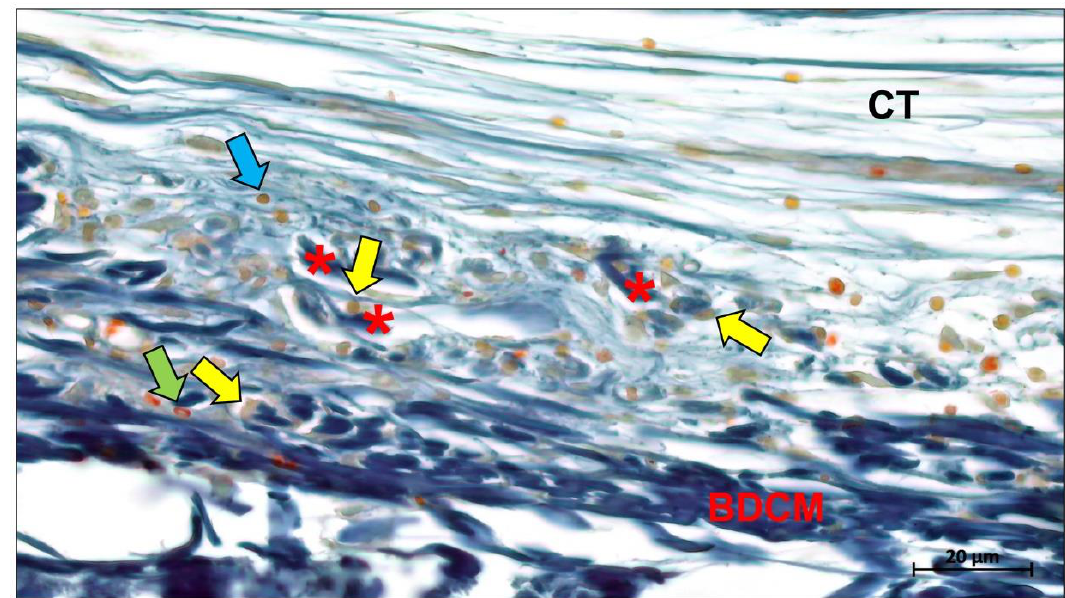
Figure 4. Representative histological image showing the inflammatory tissue reaction to a bovine dermis-derived collagen membrane (BDCM) within the subcutaneous connective tissue (CT) under- going cellular degradation at day 60 post implantationem. Red asterisks = membrane fragments, yellow arrows = macrophages, green arrow = eosinophil, blue arrow = lymphocyte (Azan staining, 400× magnification, scalebar = 20 µm).